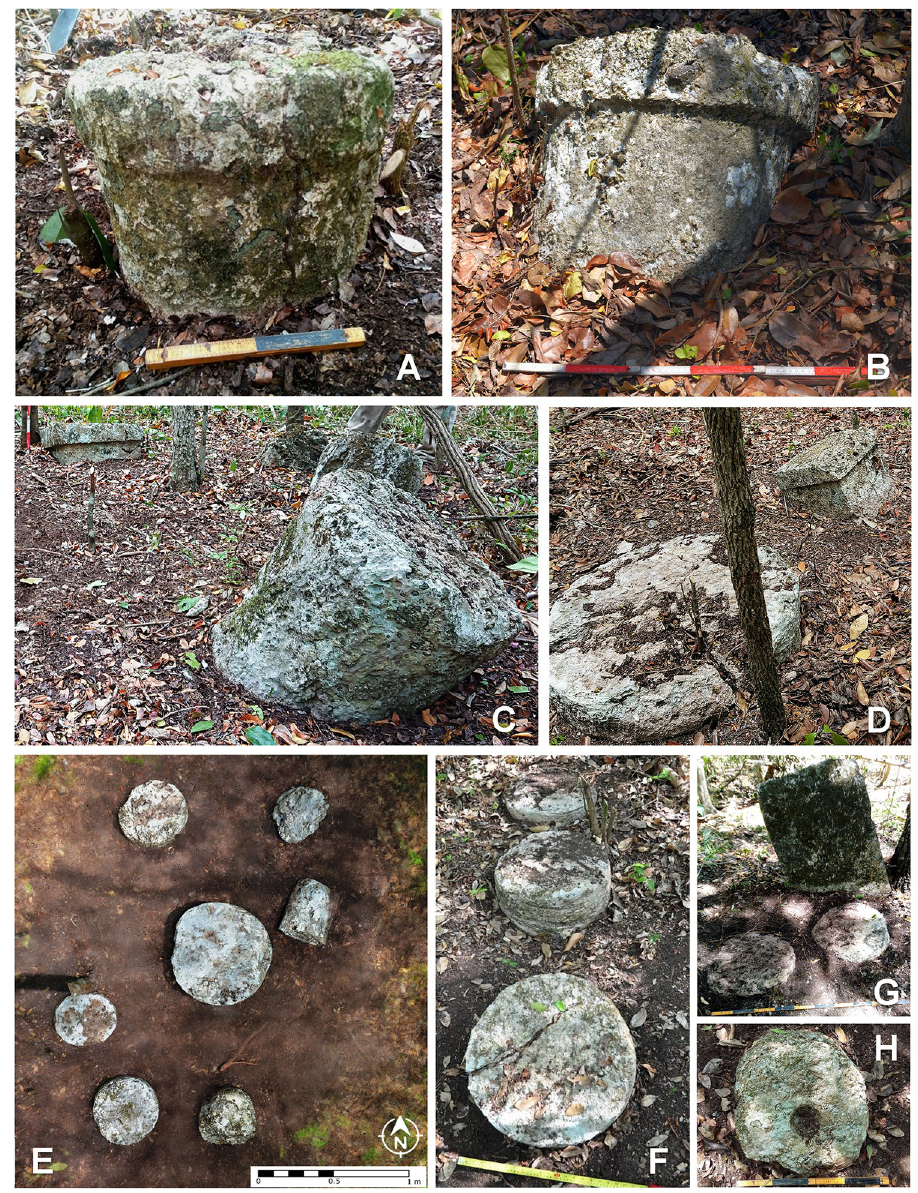
Fig 14. Flanged conical altars and quadrangular blocks in groups H26-c (A), F24-b (B), F26-b (C) and H31-d (D); stone drums in groups F12-f (E) and J14-d (F); plain stela and stone drums in group K30-a (G); stone drum with cavity in group F25-a